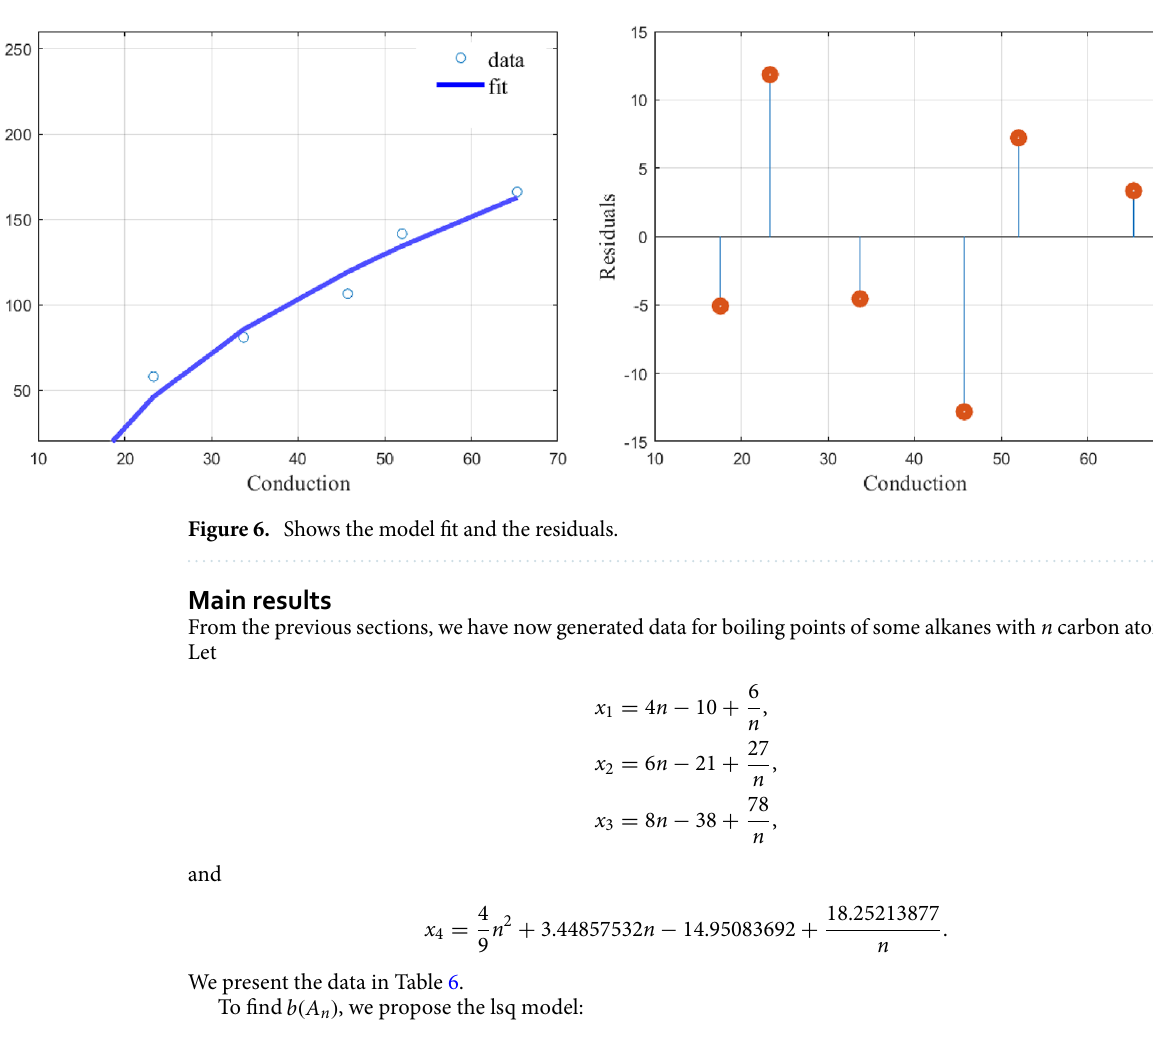
Figure 5. Shows the model fit and the residuals.